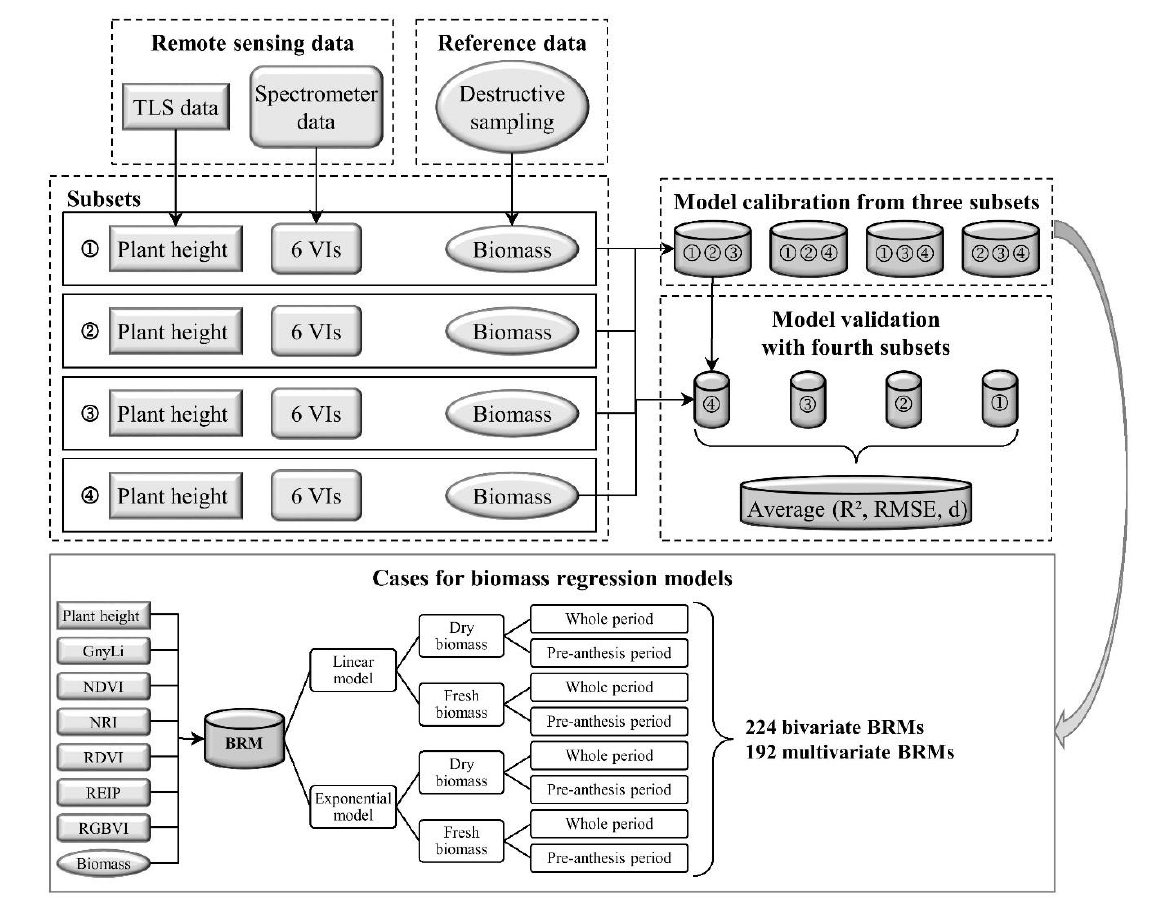
Figure 2. Workflow for the calibration and validation of the biomass regression models and distinction of cases for each